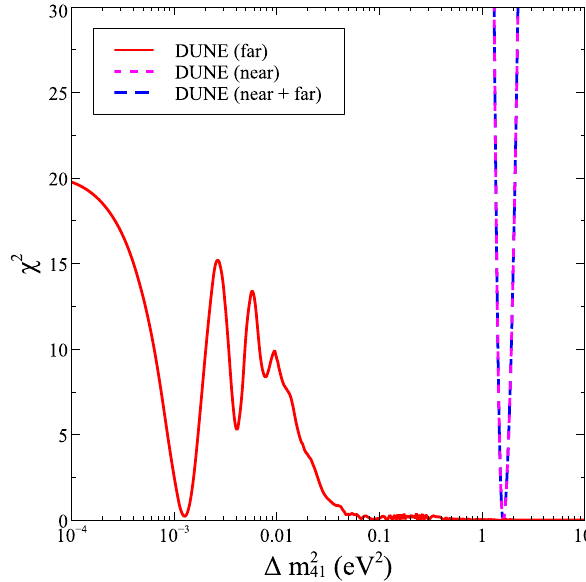
Fig. 3 Thefigureshowsthepositionsofthefakesolutions.Thereddata points show the positions of the fake solutions in (cid:2) m 2 (cid:2) m 2 andtheblackstraightlineisalinearfittoredpointscorresponding 31 = ( 1 / 2 )(cid:2) m 2 to (cid:2) m 2 41 31